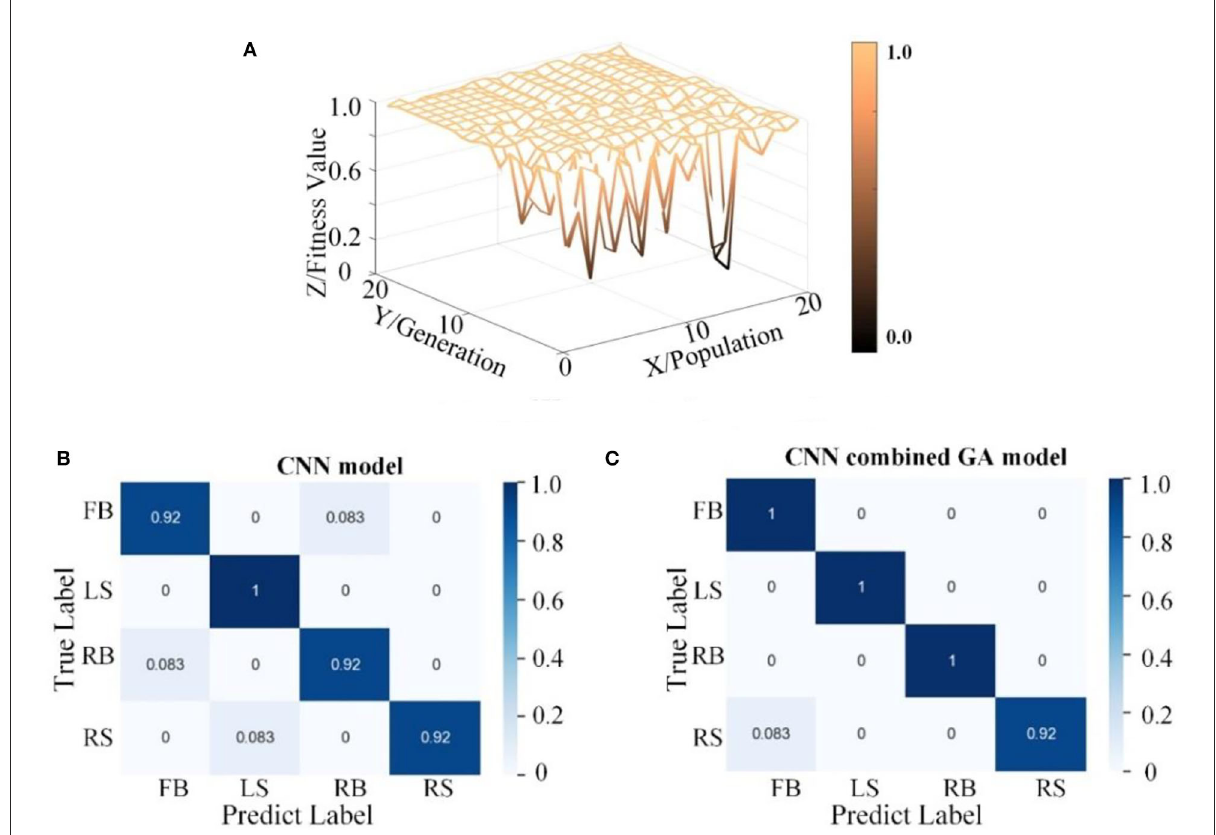
FIGURE7 Hyperparameter optimization performance from the CNN combined GA. (A) The process of hyperparameter optimization by GA. (B) The confusion matrix from CNN and CNN combined GA.